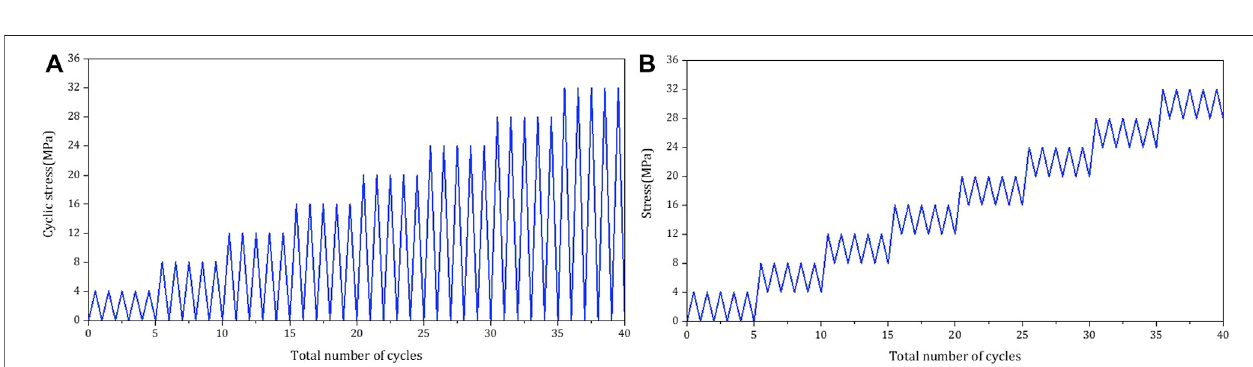
FIGURE 3 | Loading method: (A) free cycle and (B) load cycle.